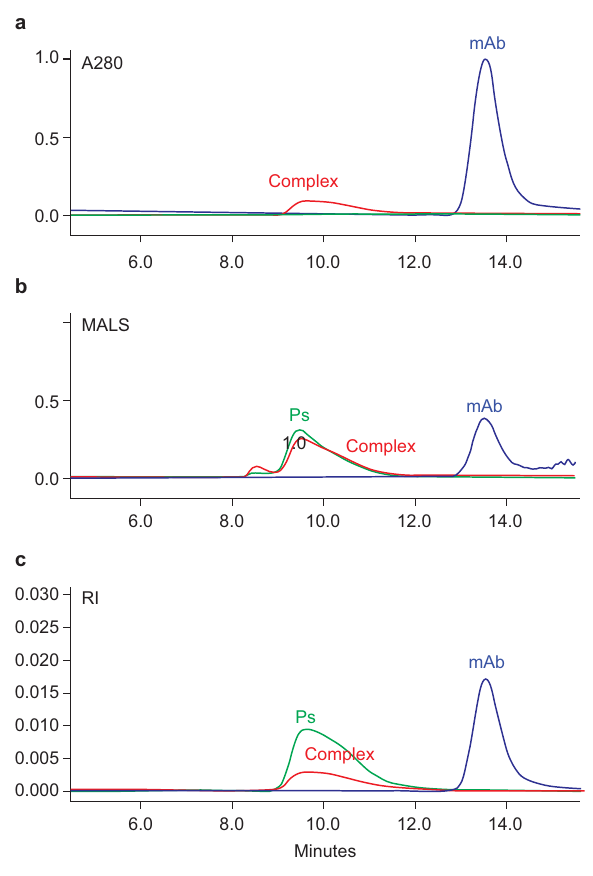
Fig. 5 Detection and analysis of antibody – polysaccharide com- plex (APC) on SEC-UV-MALS-RI. a APC peak (red) detected by UV 280 nm (A280). b APC peak (red) and unbound polysaccharide peak (green) detected by multi-angle light scattering (MALS); c APC (red) and unbound polysaccharide (green) peaks detected by refractive index (RI) detector.